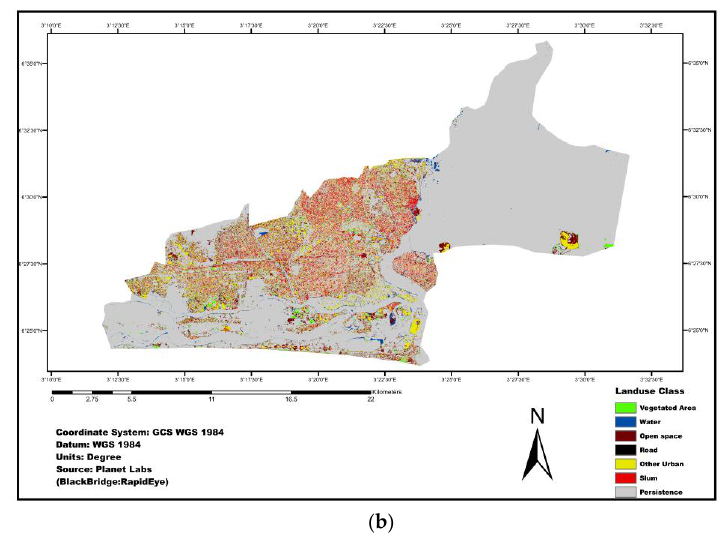
Figure 8. ( a ) The category loss intensity analysis map of the research area; and ( b ) the category gain intensity analysis map of the research area.